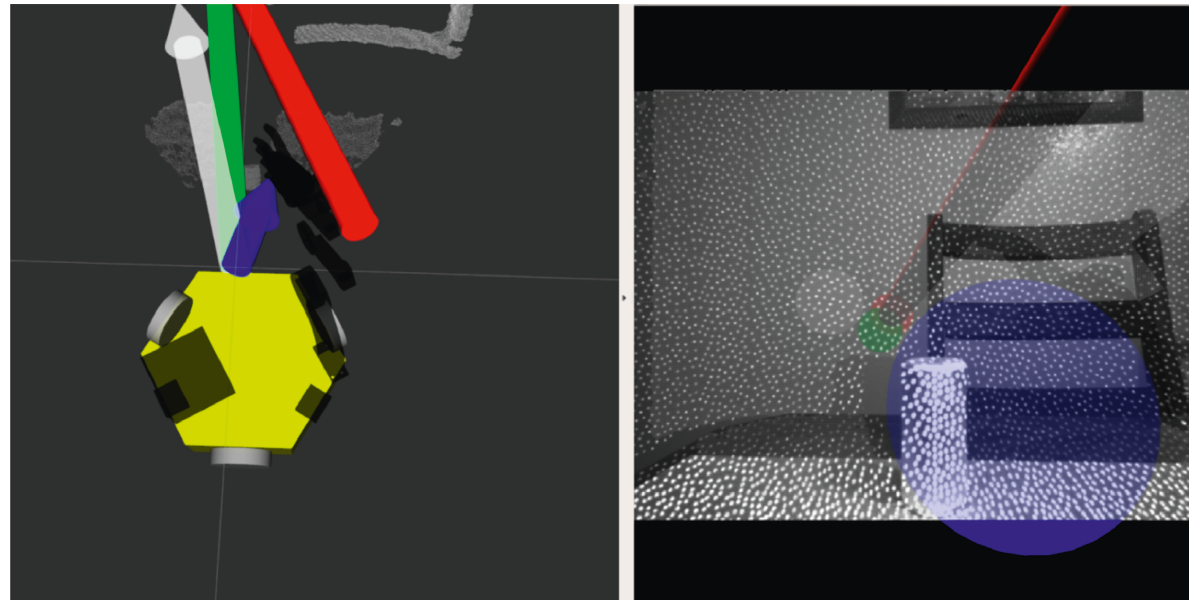
Figure 25: Visual environment of a moved camera.